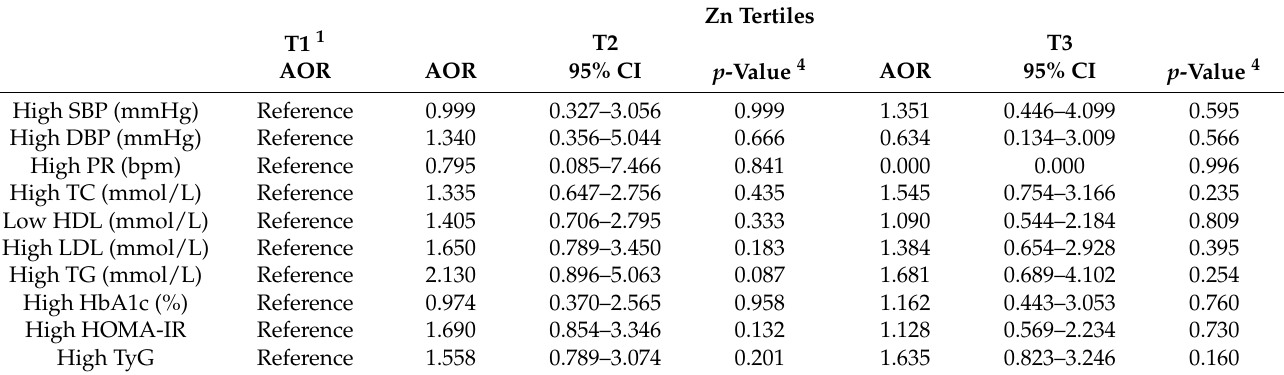
Table 4. Association between serum Zn Cu Zn/Cu and cardiometabolic markers 2,3 .